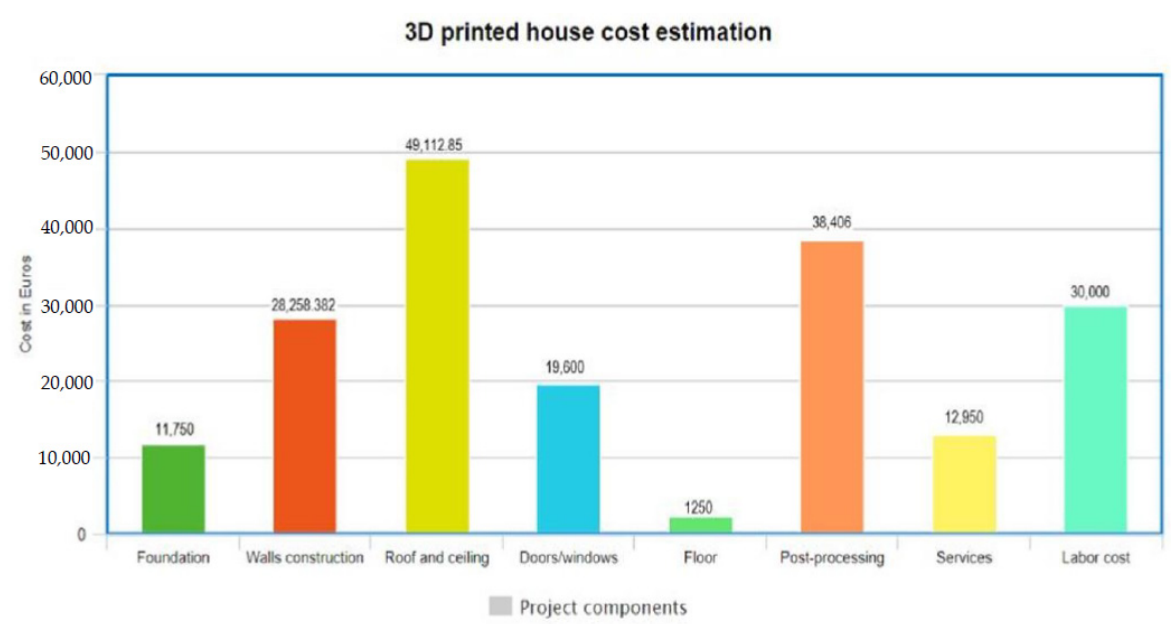
Recycling 2021 , 6 , x Figure 5. Project component effect on cost calculation. Figure 5. Project component effect on cost calculation.